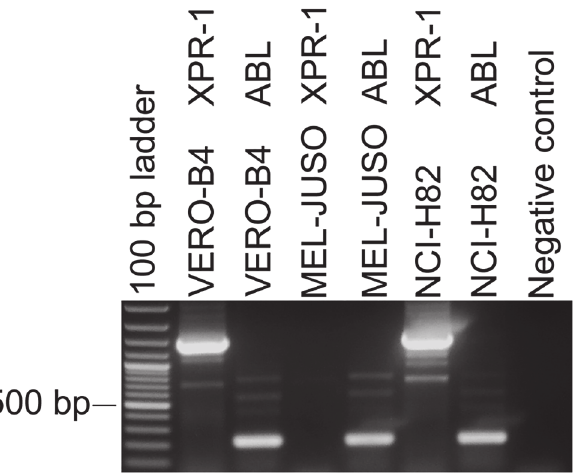
Fig 7. Detection of XPR-1 expression in the monkey cell line VERO-B4 and the human cell lines MEL-JUSO and NCI-H82 by RT-PCR. VERO-B4 and NCI-H82 express XPR-1 mRNA in significant amounts (1455 bp), whereas MEL-JUSO lacks the expression of XPR-1 transcripts. The demonstration of the ubiquitously expressed ABL mRNA was used to show the integrity of the mRNA and the cDNA (216